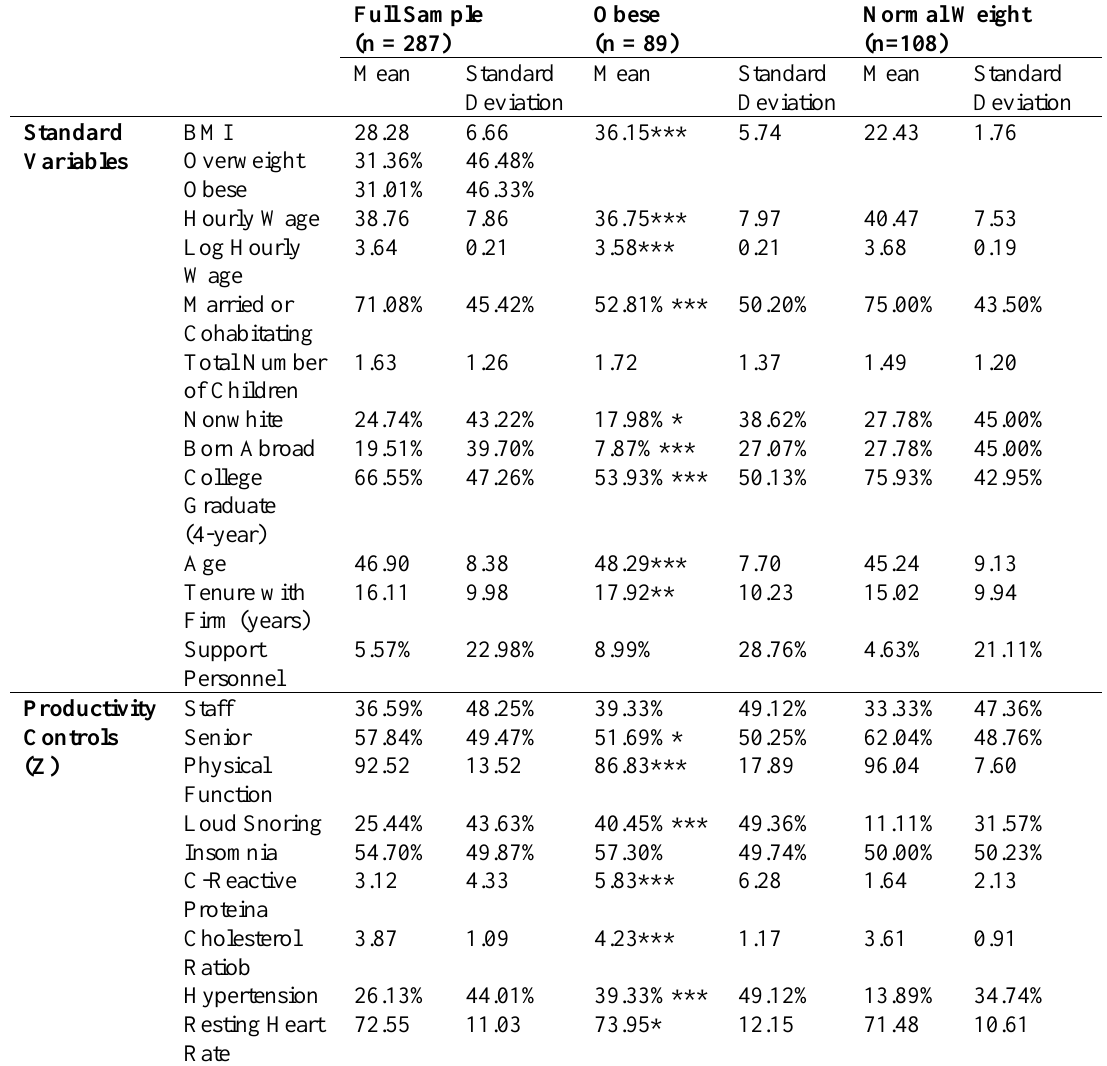
Table 1a: Summary statistics